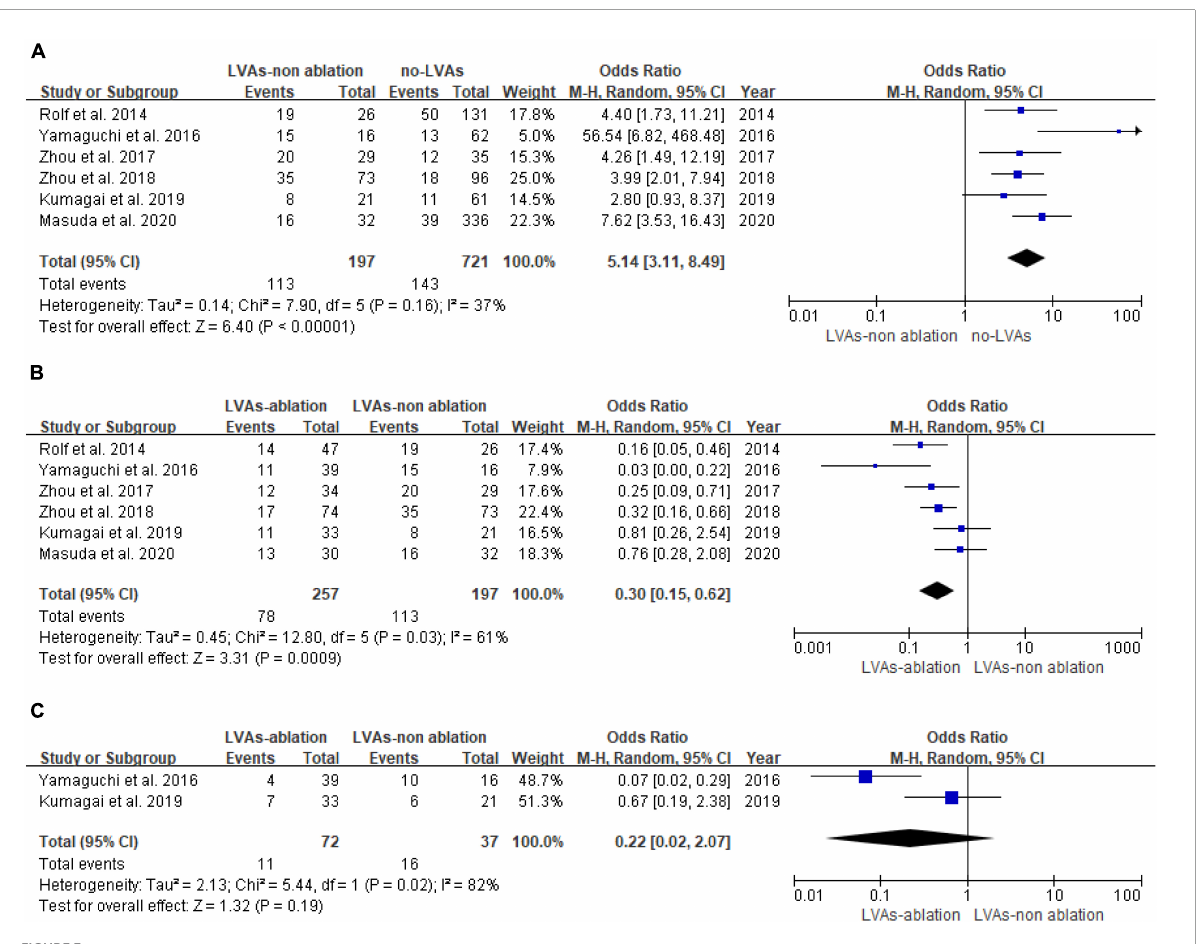
FIGURE3 Forest plot of arrhythmia recurrence. (A) Recurrence of atrial fibrillation patients with or without LVAs after conventional ablation. (B) Recurrence of LVAs patients with or without LVAs substrate modification after first procedure. (C) Recurrence of LVAs patients with or without LVAs substrate modification after multiple